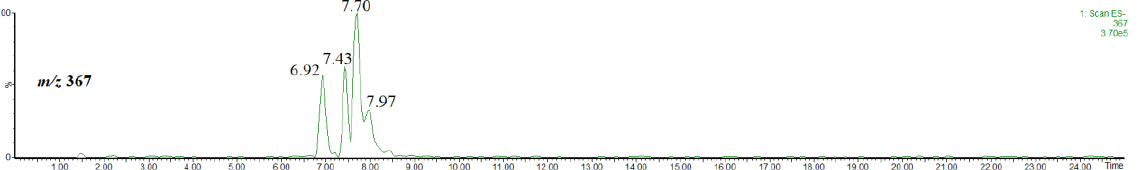
Figure 3. Single ion chromatogram of the ion at m/z 367, thus the [M-H] − ion of methyl chlorogenate and its isomers.